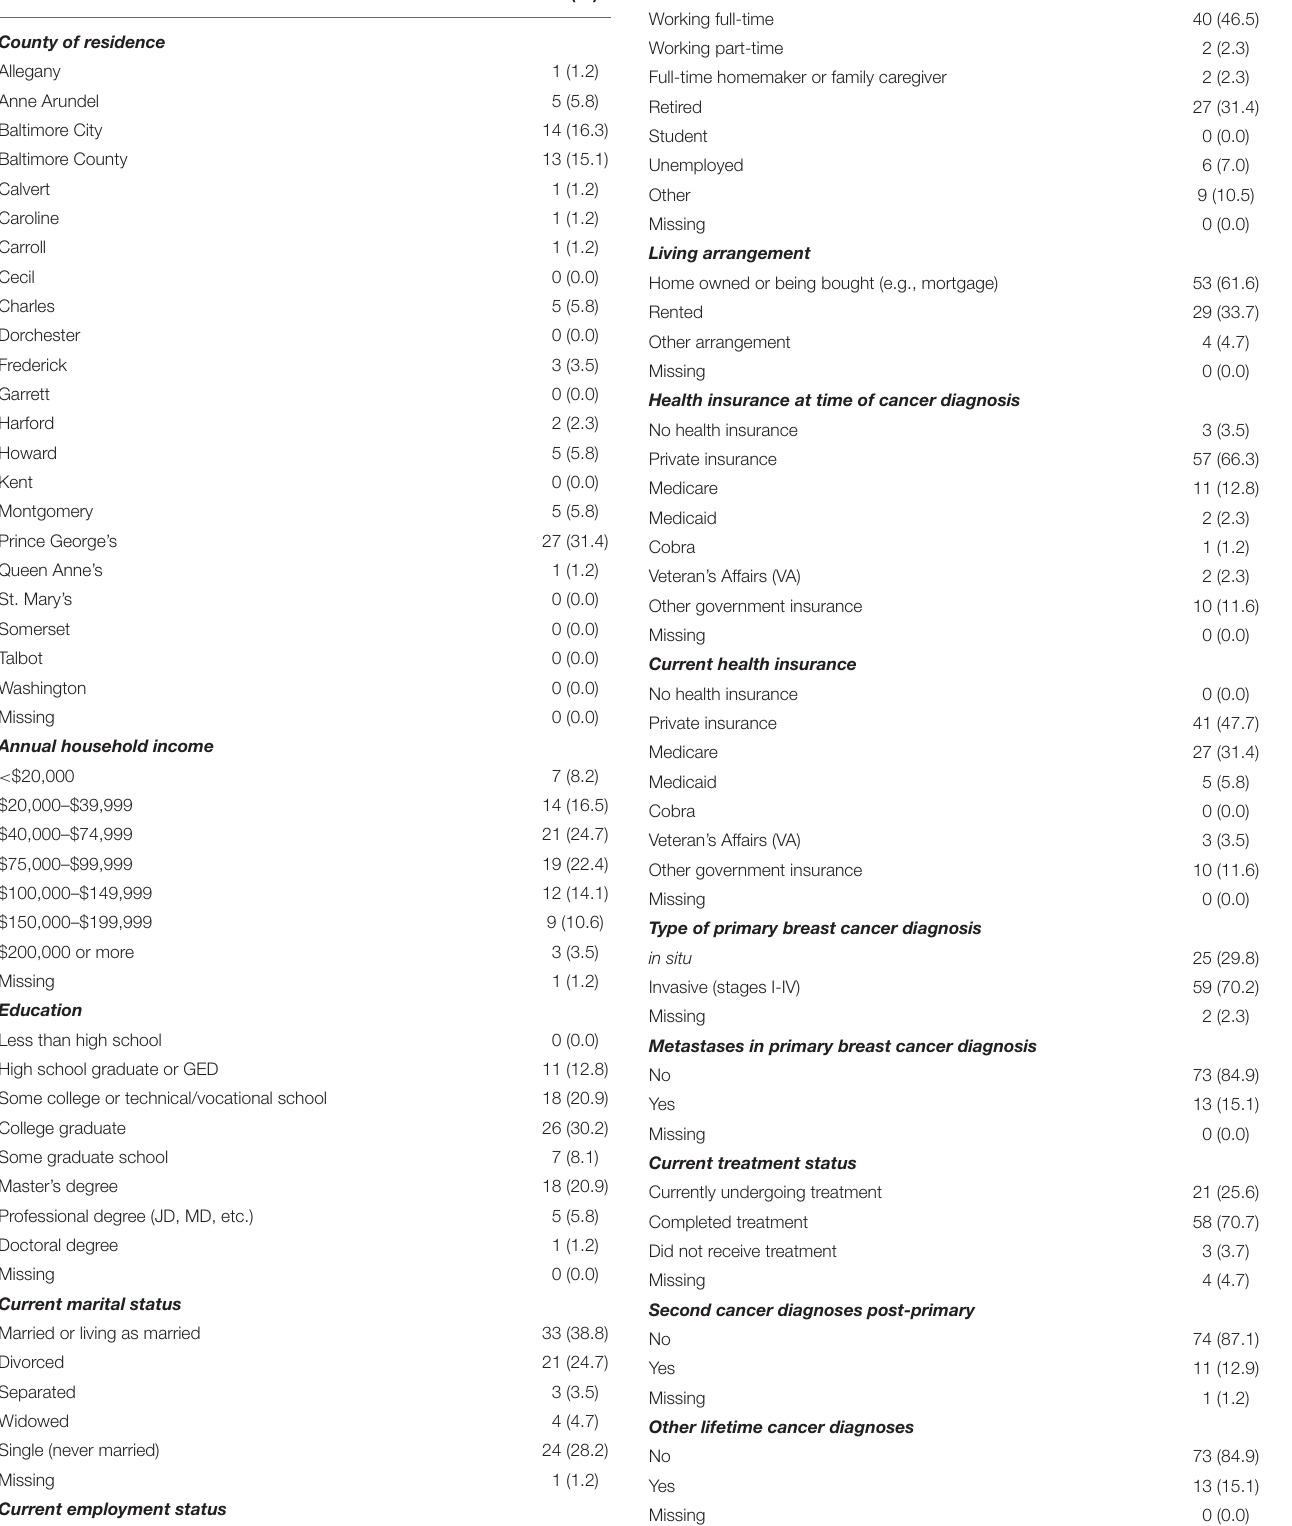
TABLE 2 | Preliminary descriptive results of study participants with completed surveys ( N = 86).